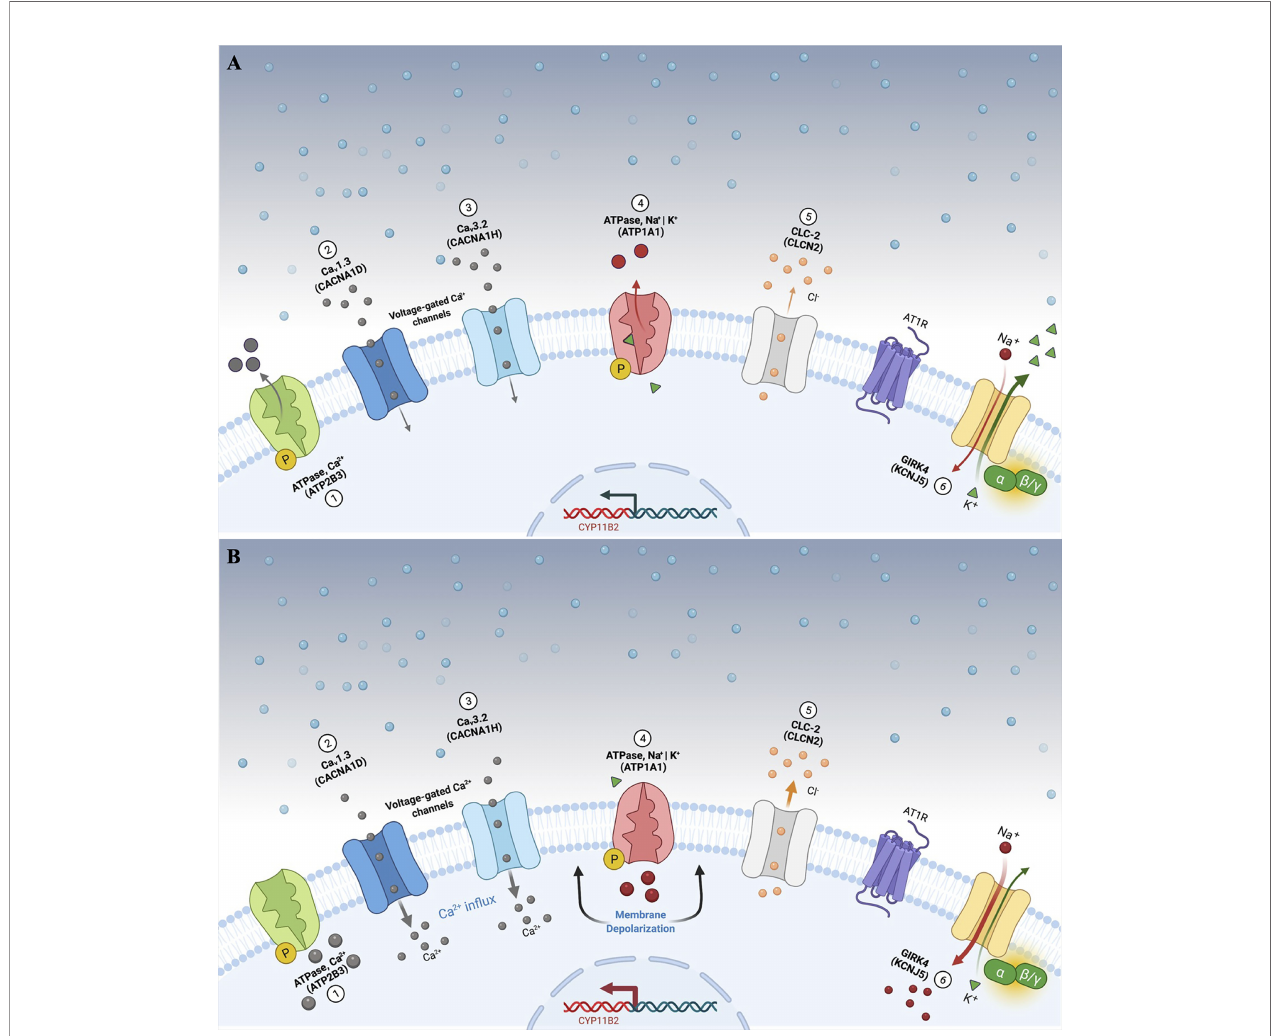
FIGURE 1 | Aldosterone secretion in adrenal zona glomerulosa cells under physiological (A) and pathological (B) conditions. (A) Adrenal glomerulosa cell resting. The normal resting potential of zona glomerulosa cells is hyperpolarized (highly negative membrane potential). Activation of the angiotensin receptor (AT1R) by angiotensin II or extracellular hyperkalemia results in membrane depolarization and calcium in fl ux via activated voltage-gated calcium channels. Calcium in fl ux activates signaling to increase expression of aldosterone synthase ( CYP11B2 ) and ultimately aldosterone production. (B) Genetic alterations leading to cell membrane depolarization, intracellular ionic modi fi cation, and autonomous aldosterone secretion in PA. Pathogenic variants in the KCNJ5 gene (G-protein-activated inward recti fi er potassium channel GIRK4) [6] promote loss of channel K + selectivity and increase permeability to Na + , leading to membrane depolarization and calcium in fl ux via voltage-gated calcium channels. Similarly, impaired ATPase, Ca 2+ (ATP2B3) [1]; Ca v 1.3 (CACNA1D) [2]; Ca v 3.2 (CACNA1H) [3]; ATPase, Na + | K + (ATP1A1) [4], and CLC-2 (CLCN2) [5] function results in cell membrane depolarization, calcium in fl ux and autonomous aldosterone secretion. PA, primary